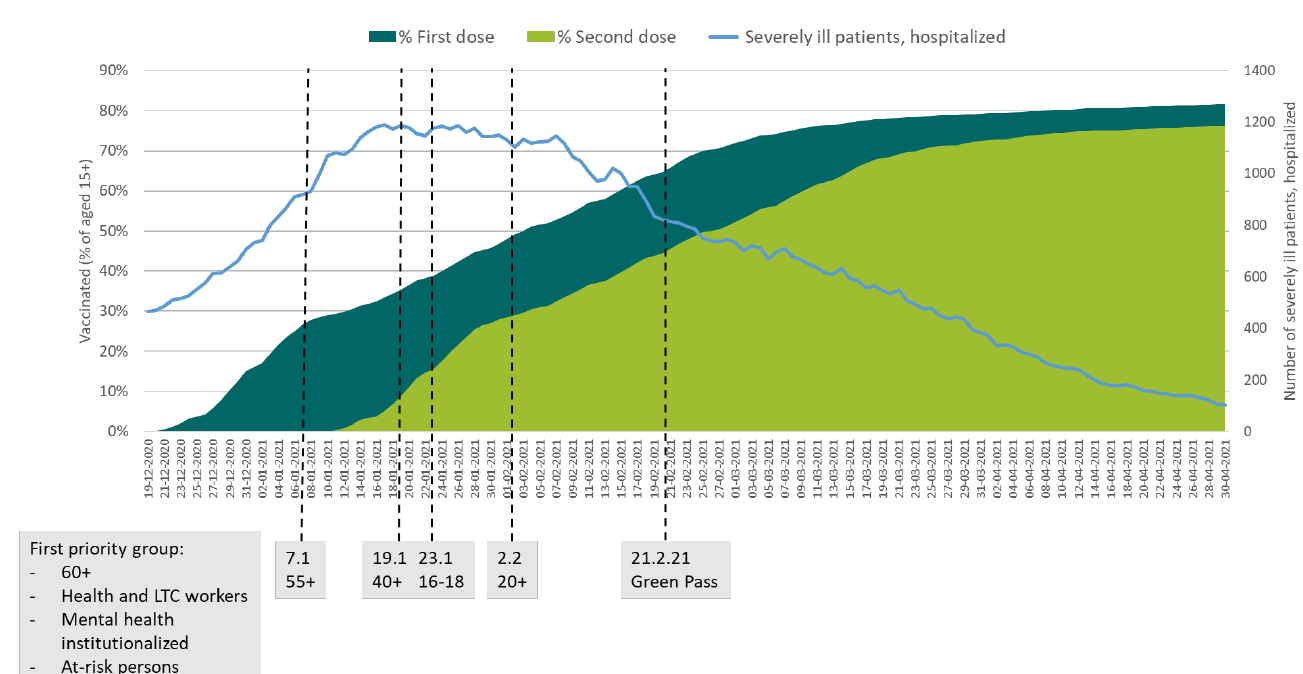
Figure 1. Vaccination rollout, hospitalized, prioritisation, and implementation of the Green Pass. (Sources: authors’ own compilation based on https://datadashboard.health.gov.il/COVID-19/general, accessed on 18 October 2021 and [12]; Note: vaccination rates for the population aged 15+ for whom the vaccine was approved by the manufacturer.